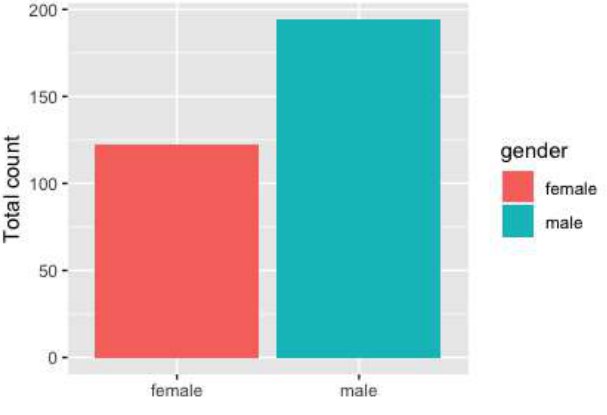
Figure 3: Gender-wide Distribution of Respondents (Source: Authors‟